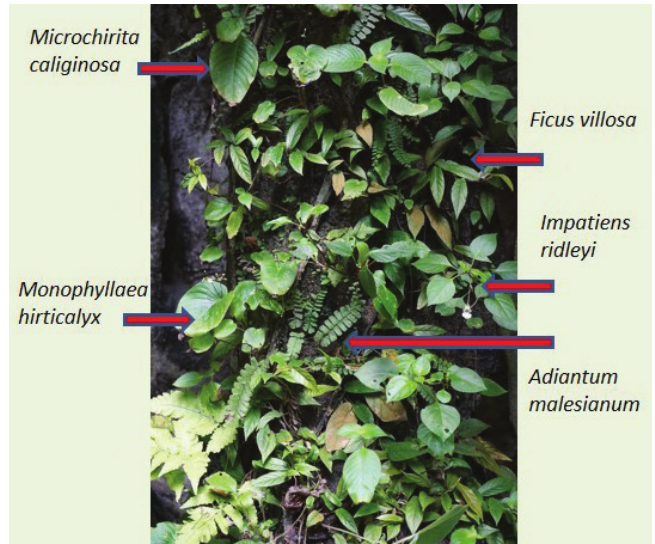
Figure 3. The vertical shaded wall microhabitat illustrates high biodiversity of limestone